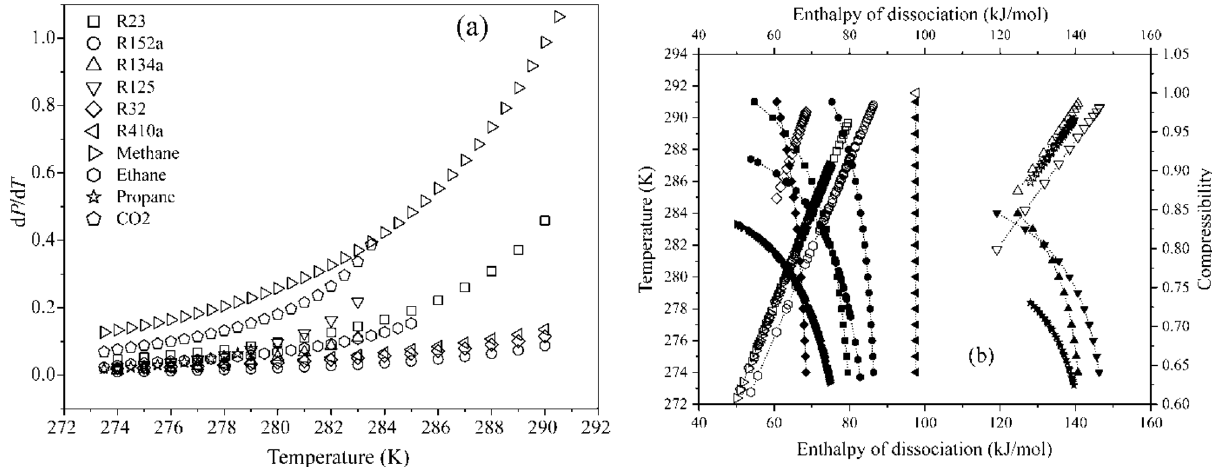
Figure 5. Model estimates of ( a ) change in the HLV equilibrium pressure per unit change in operating temperature ( b ) enthalpy of dissociation with respect to operating temperature and compressibility of refrigerant formers. The legends are shared between both figures and are detailed in figure ( a ). In figure ( b ), the solid and hollow interiors of legends denote the temperature and compressibility ranges, respectively.